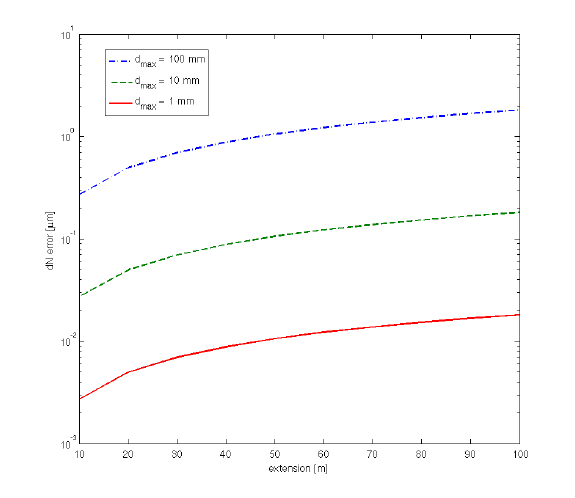
Figure 10. Theeffectoflinearsubsidenceonthegravityfieldasfunc- tion of the length of the subsiding